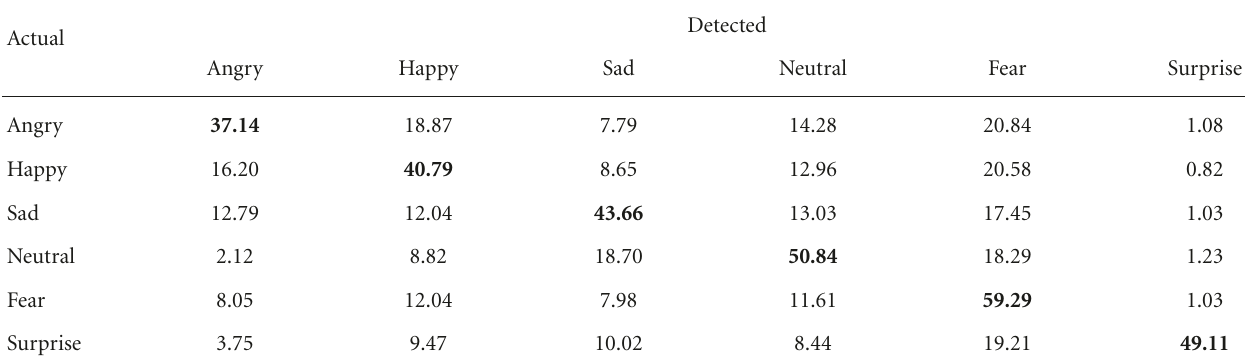
Table 9: Six emotions recognition rate (%) balanced speaker and text independent test-utterance based: 100 utterances per emotion, random sequence of speakers, SNR = 10 dB.